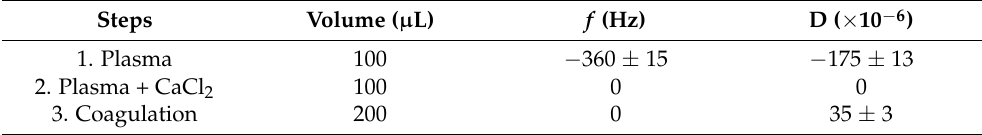
Table 1. Resonance frequency ( f ) and dissipation (D) of the fifth overtone due to changes in the adsorption on the NoCa surface. Step 1 corresponds to the passage from air to plasma (liquid). Step 2 corresponds to the addition of plasma with CaCl 2 (liquid) to the plasma (liquid). Step 3 corresponds to coagulation.